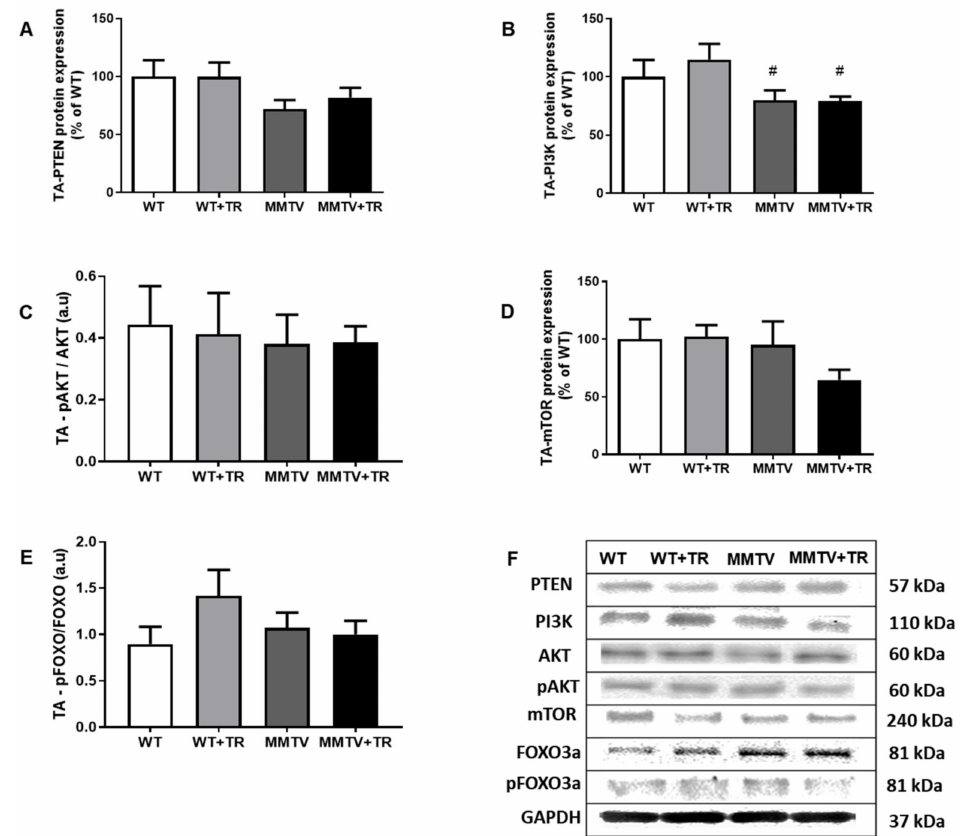
Figure 10. MMTV-PyMT non-cachectic mice: PTEN/PI3K/AKT/mTOR pathway proteins expression in tibialis anterior (TA) using Western blot. ( A ) PTEN protein expression. ( B ) PI3K protein expression. ( C ) ratio between pAKT and AKT protein expression. ( D ) mTOR protein expression. ( E ) pFOXO3a and FOXO3a protein expression ratio. ( F ) Proteins PTEN, PI3K, AKT, mTOR, FOXO3a and pFOXO3a representative blots. Groups: WT—wild type sedentary ( n = 7); WT+TR—wild type trained ( n =